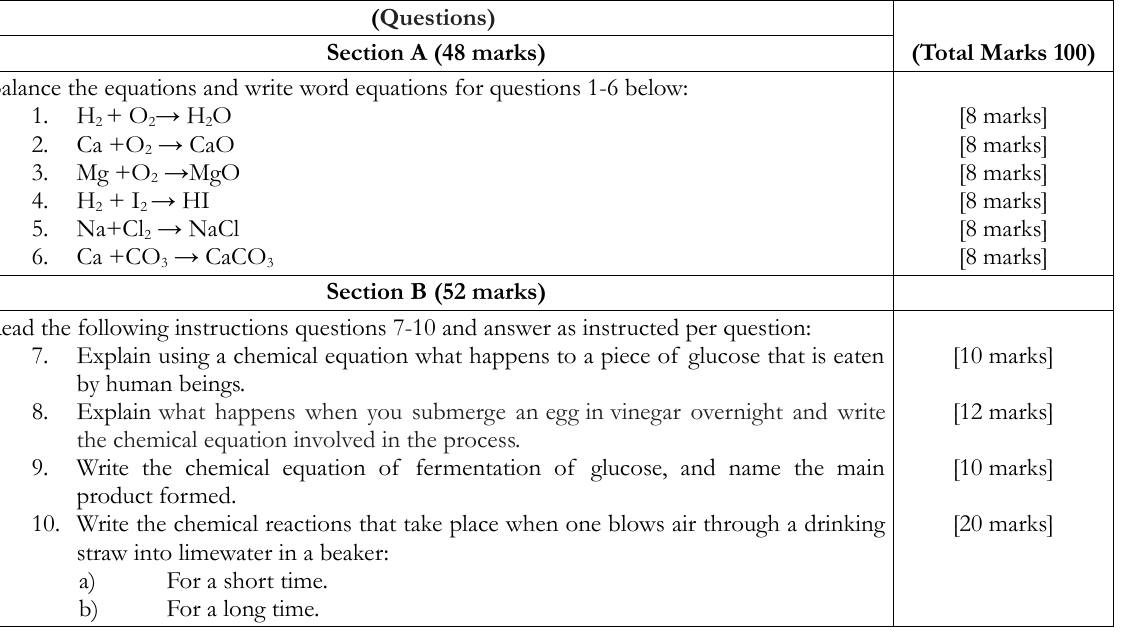
Table 2. Performance Test for Grade nine Physical